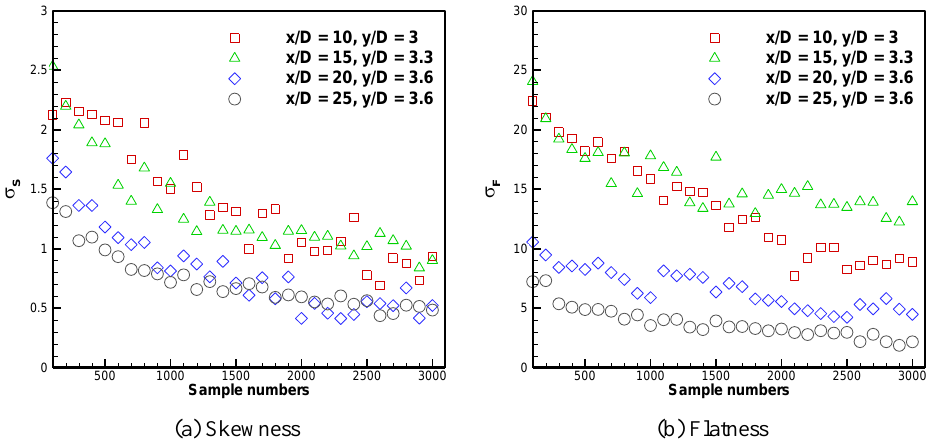
Fig. 2 Dependence of sample number on the standard deviations of both skewness and flatness factors at four position around the edge of the